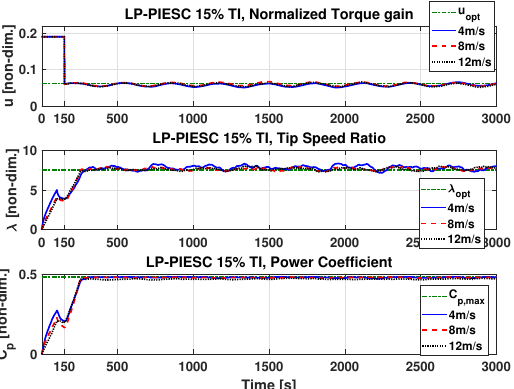
Figure 9. Performance of LP-PIESC with the parameters shown in Table 3 and wind input with 15% TI. Normalized torque gain u ( top ), tip speed ratio λ ( middle ), and estimated power coefficient C p ( bottom ). The dashed horizontal lines indicate optimal parameters u opt , λ opt and C P ,max . The LP- PIESC is turned on at 150 s.